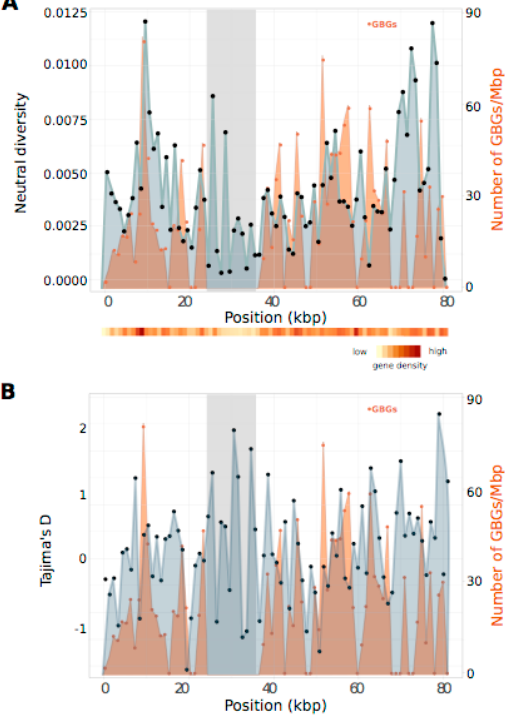
Figure 3. Population genetic statistics for the sex chromosome of Ectocarpus siliculosus . ( A ) Sliding window analysis of neutral diversity ( π ) in 1 kb non-overlapping windows along the concatenated ddRAD sequences of the sex chromosome. Values of π are indicated by black dots; ( B ) Sliding window analysis of Tajima’s D in 1 kb windows (indicated by black dots) along the concatenated sex chromosome sequence. The number of genes with differential expression in the sporophyte or gametophyte generation (generation-biased genes or GBGs) normalized by the physical distance covered by the concatenated 1 kb ddRAD window are marked in orange. Global gene density along the concatenated sex chromosome sequence is represented by the heatmap. The position of the sex-determining region is shaded in gray.